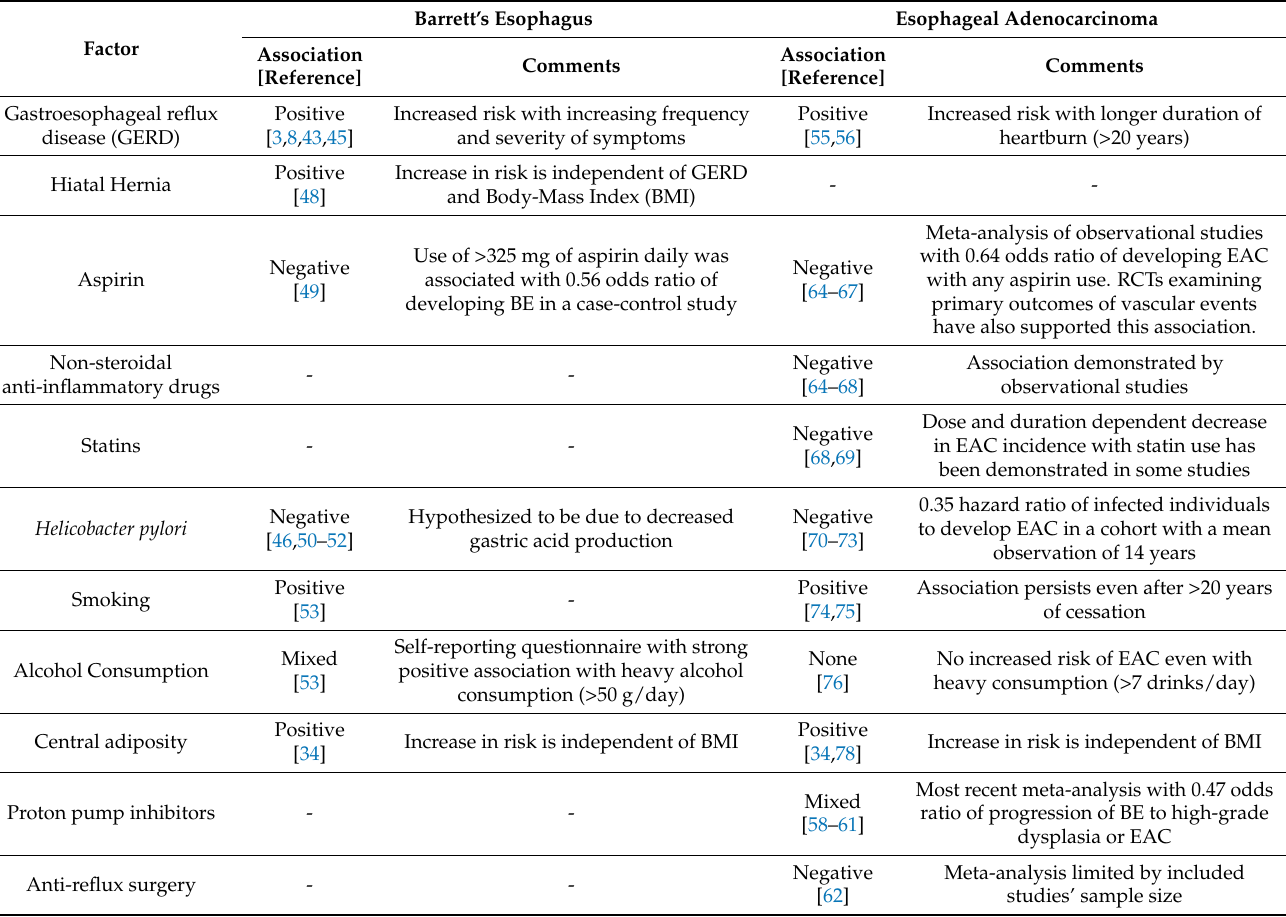
Table 2. Risk factors for development of Barrett’s Esophagus (BE) and Esophageal Adenocarcinoma